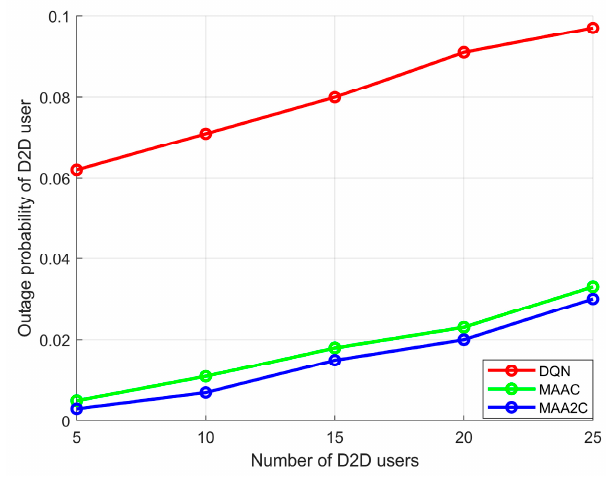
Figure 7. Outage probability of D2D users.